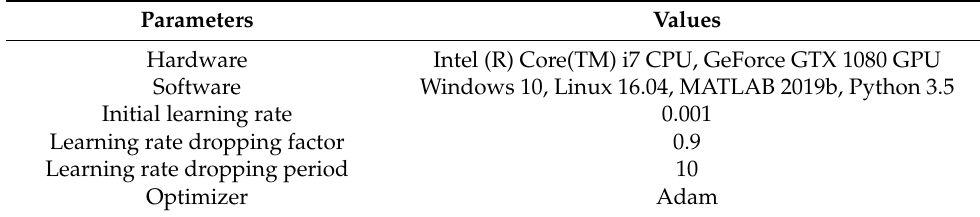
Table 1. Hardware, software, and parameters configurations.